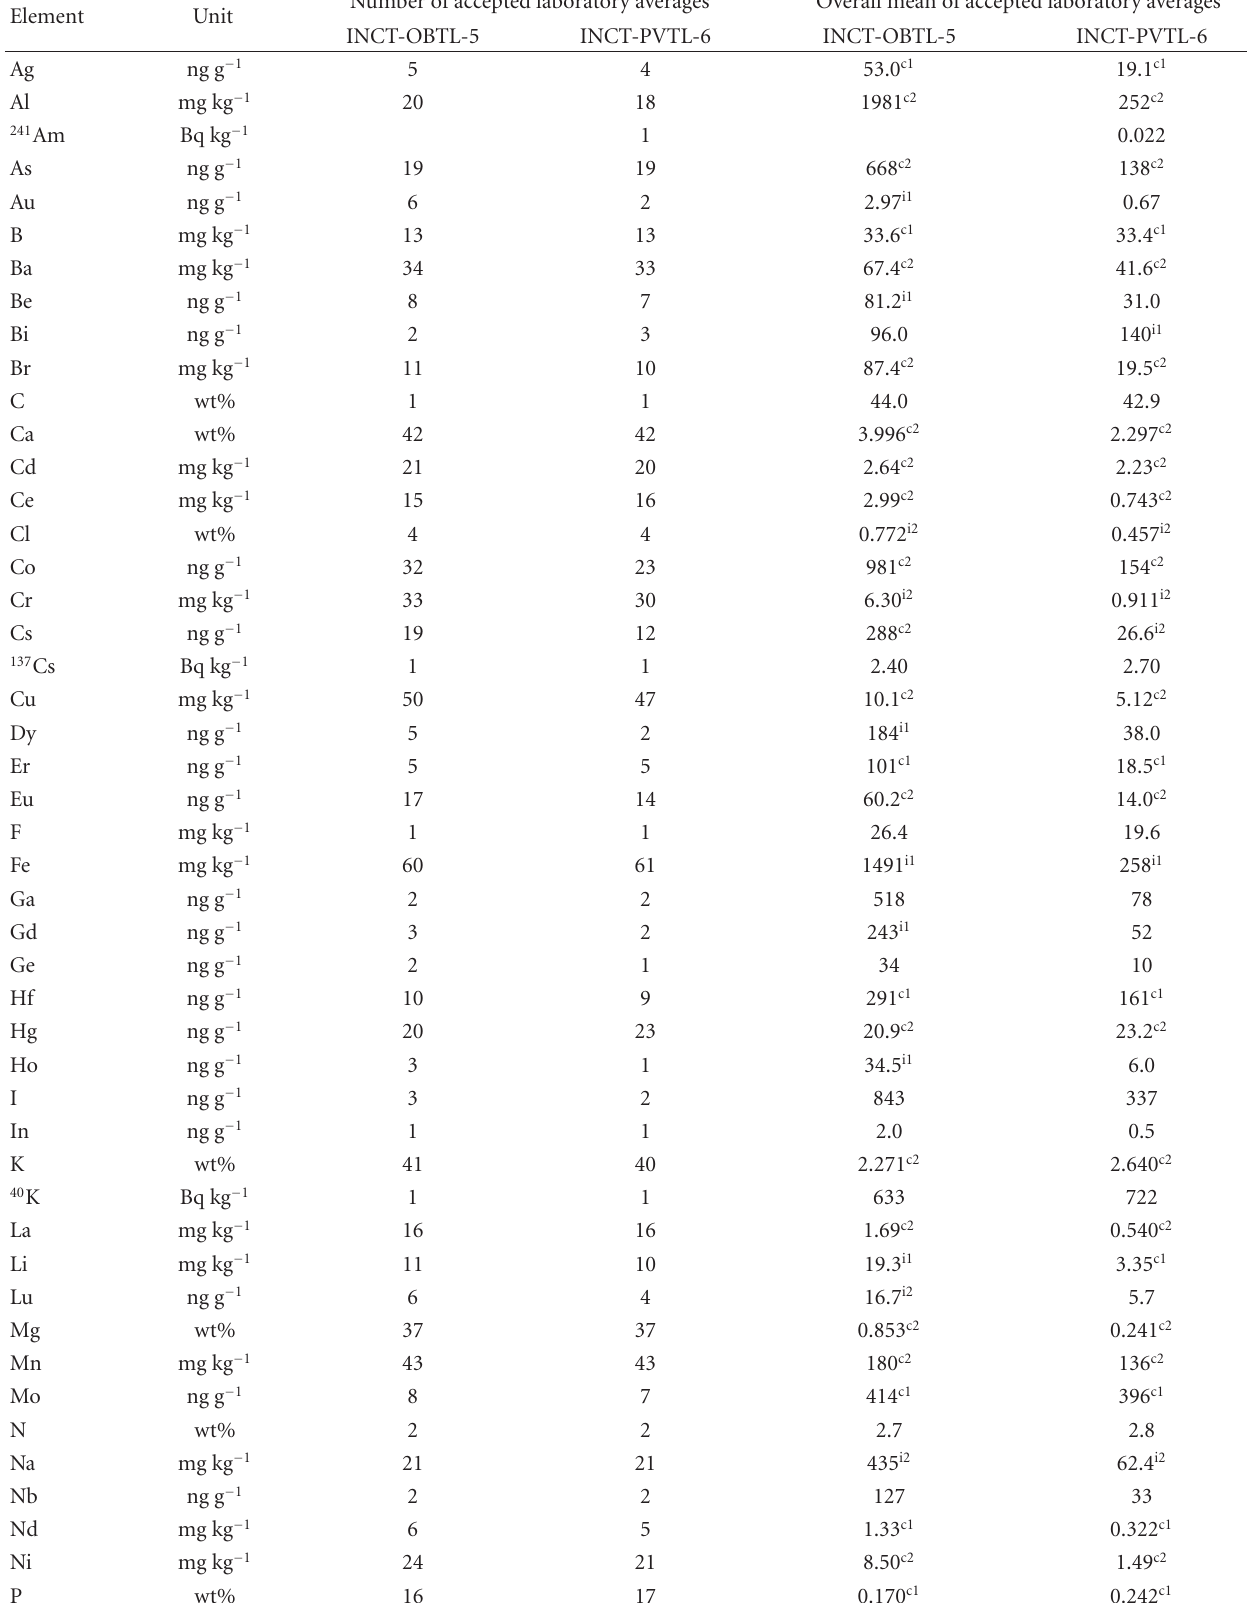
Table 2: Analytical results obtained for the candidate reference